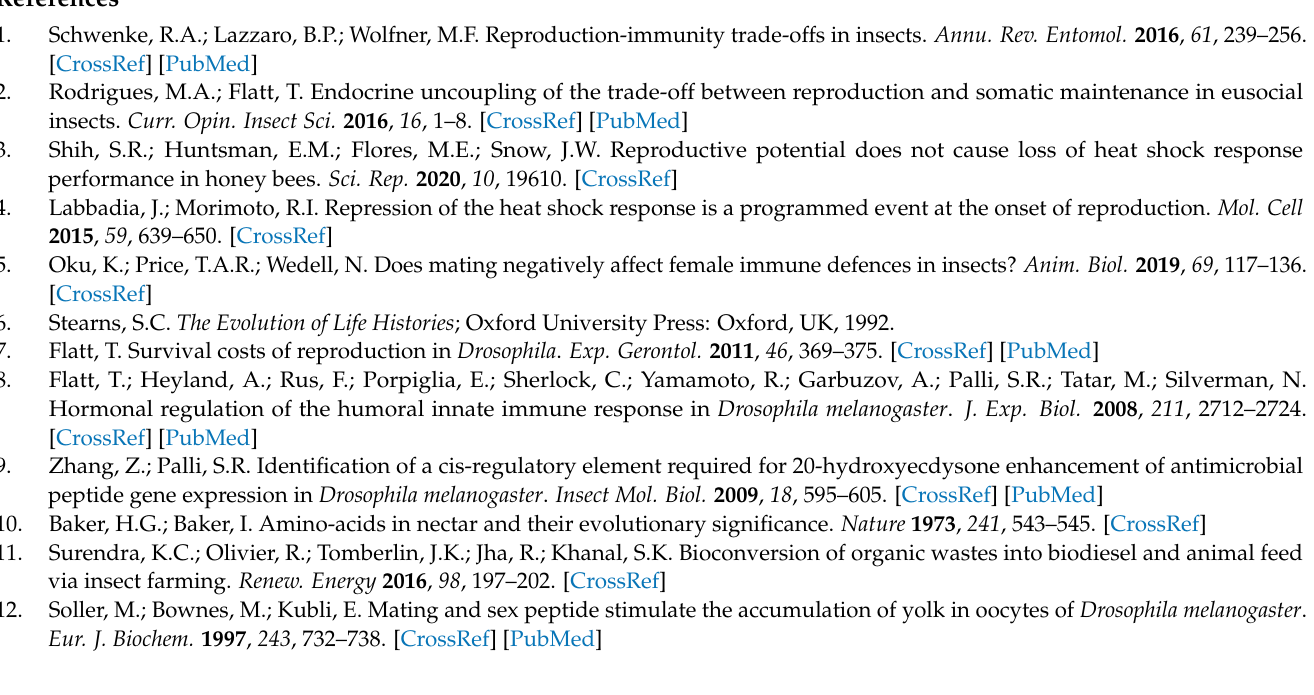
of the quality of all sample sequencing data. Table S3 Pearson’s correlation coefficient. Table S4 Differentially expressed genes (DEGs) between M1 h-vs.-V1 h group. Table S5 Differentially expressed genes (DEGs) between M6 h-vs.-V6 h group. Table S6 Differentially expressed genes (DEGs) between M24 h-vs.-V24 h group. Table S7 Identical DEGs between groups. Table S8 GO enrichment of DEGs from different groups. Table S9 KEGG enrichment of DEGs from different groups. Table S10 Progesterone-mediated oocyte maturation related